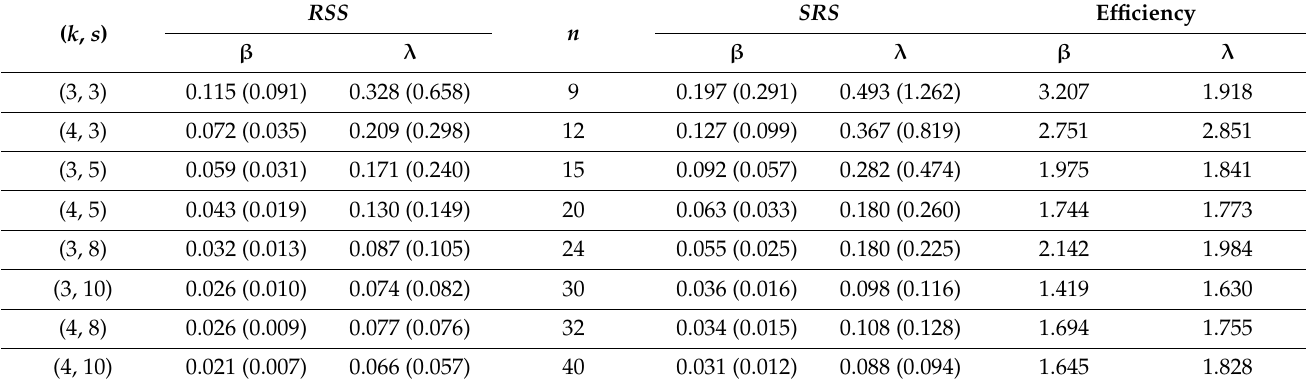
Table 1. The bias ( MSE ) and efficiency of the MLE parameters β and λ when β = 0.5 and λ = 1.